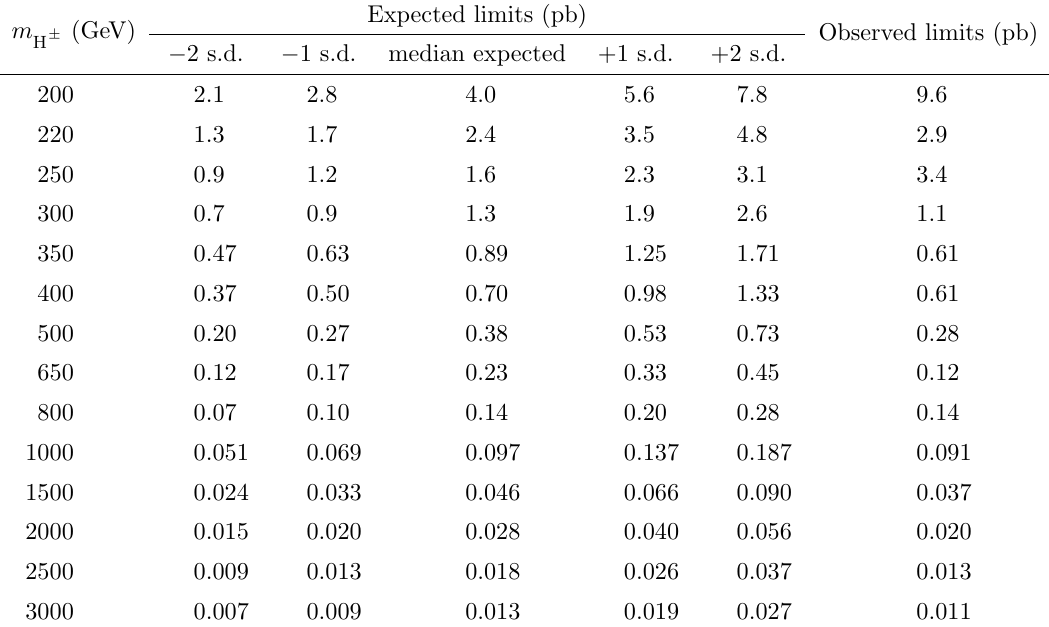
(H (cid:6) tb) with the single-lepton and dilepton H (cid:6) B !